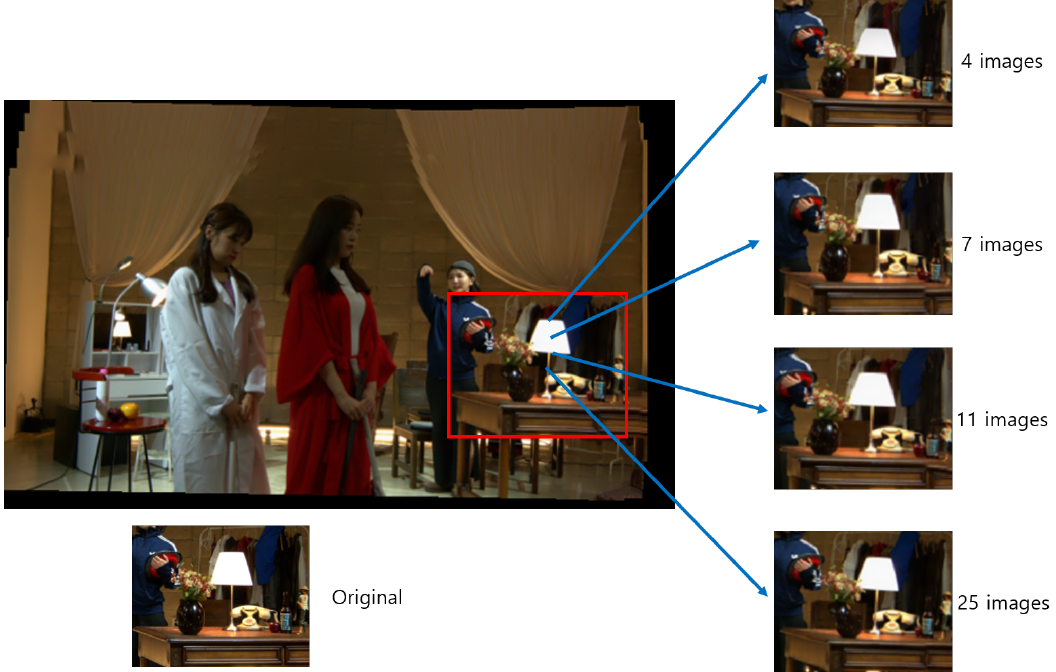
Figure 20. View synthesis with different numbers of images shows that the quality with seven or 11 images is competitive with the one with 25